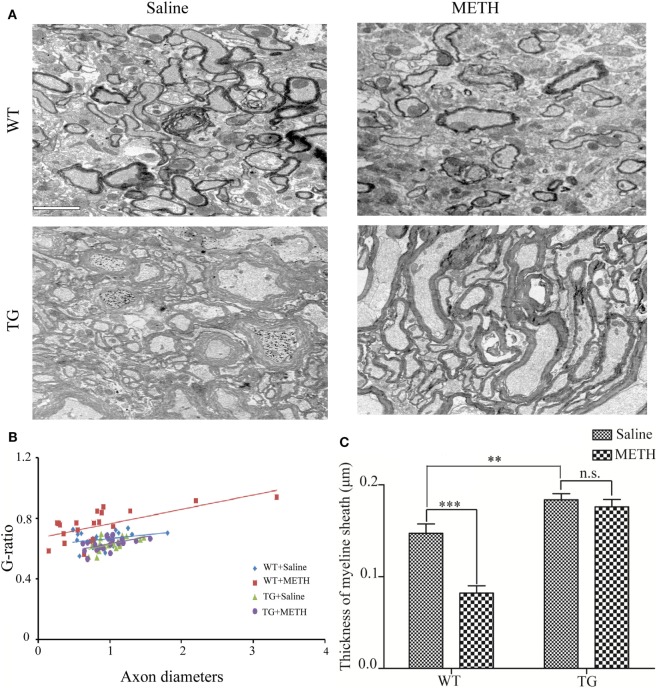
Overexpression of thioredoxin-1 (Trx-1) prevented decrease of myelin thickness induced by methamphetamine (METH) in spinal cord. (A) EM images show overexpression of Trx-1 prevented decrease of myelin thickness induced by METH in spinal cord average myelin thickness: control mice 0.147 ± 0.007; METH mice 0.082 ± 0.008; TG mice 0.183 ± 0.004; and TG mice by METH 0.179 ± 0.008. (B) A significant increase in the g-ratio in mice by METH. Overexpression of Trx-1 suppressed increase of g-ratio by METH in spinal cord. (C) Overexpression of Trx-1 prevented decrease of myelin thickness induced by METH in spinal cord. Values are means ± SE (N = 6); **P < 0.01, and ***P < 0.001.